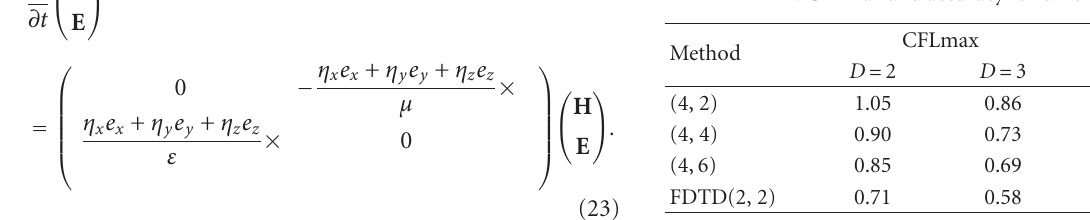
Figure 3: Numerical dispersion curves for (4,4) scheme and FDTD(2,2) method. Table 1: CFLmax and accuracy for di ff erent